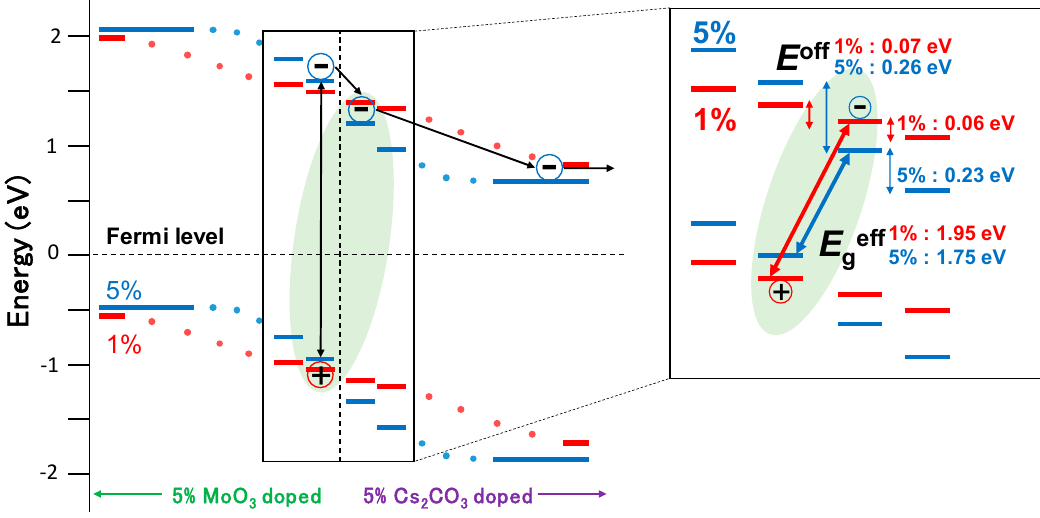
Figure 5. Schematic energy diagram and charge dissociation and recombination mechanisms in organic pn- homojunction SCs. The inset shows the energy gap between adjacent molecules at the pn- interface with 1% (red) and 5% (blue) doping.